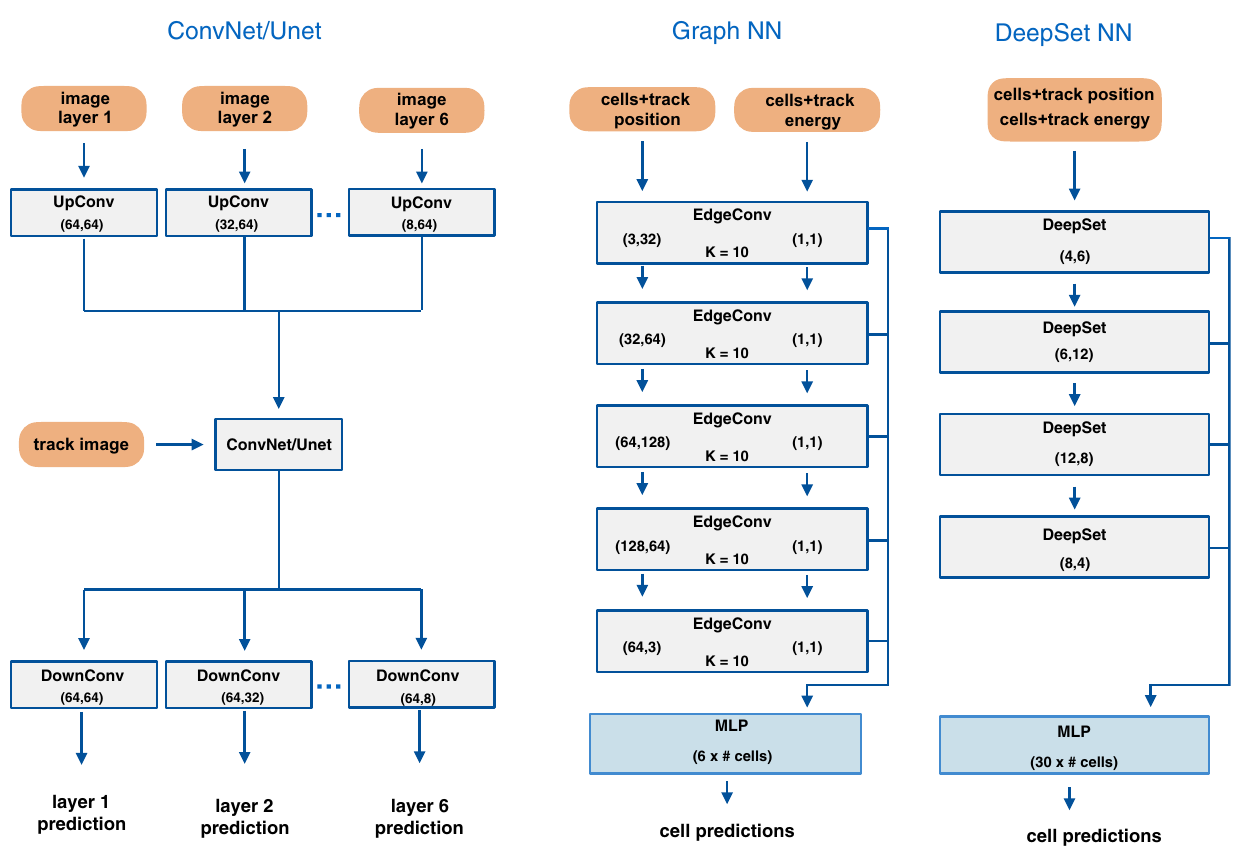
Fig. 10 An illustration of the general convolutional network with the UNet variant is shown on the left. In the middle the general flow of the graph neural network with dynamic EdgeConvolution layers is illus- trated. Each cells and the track is treated as a node, which are passed